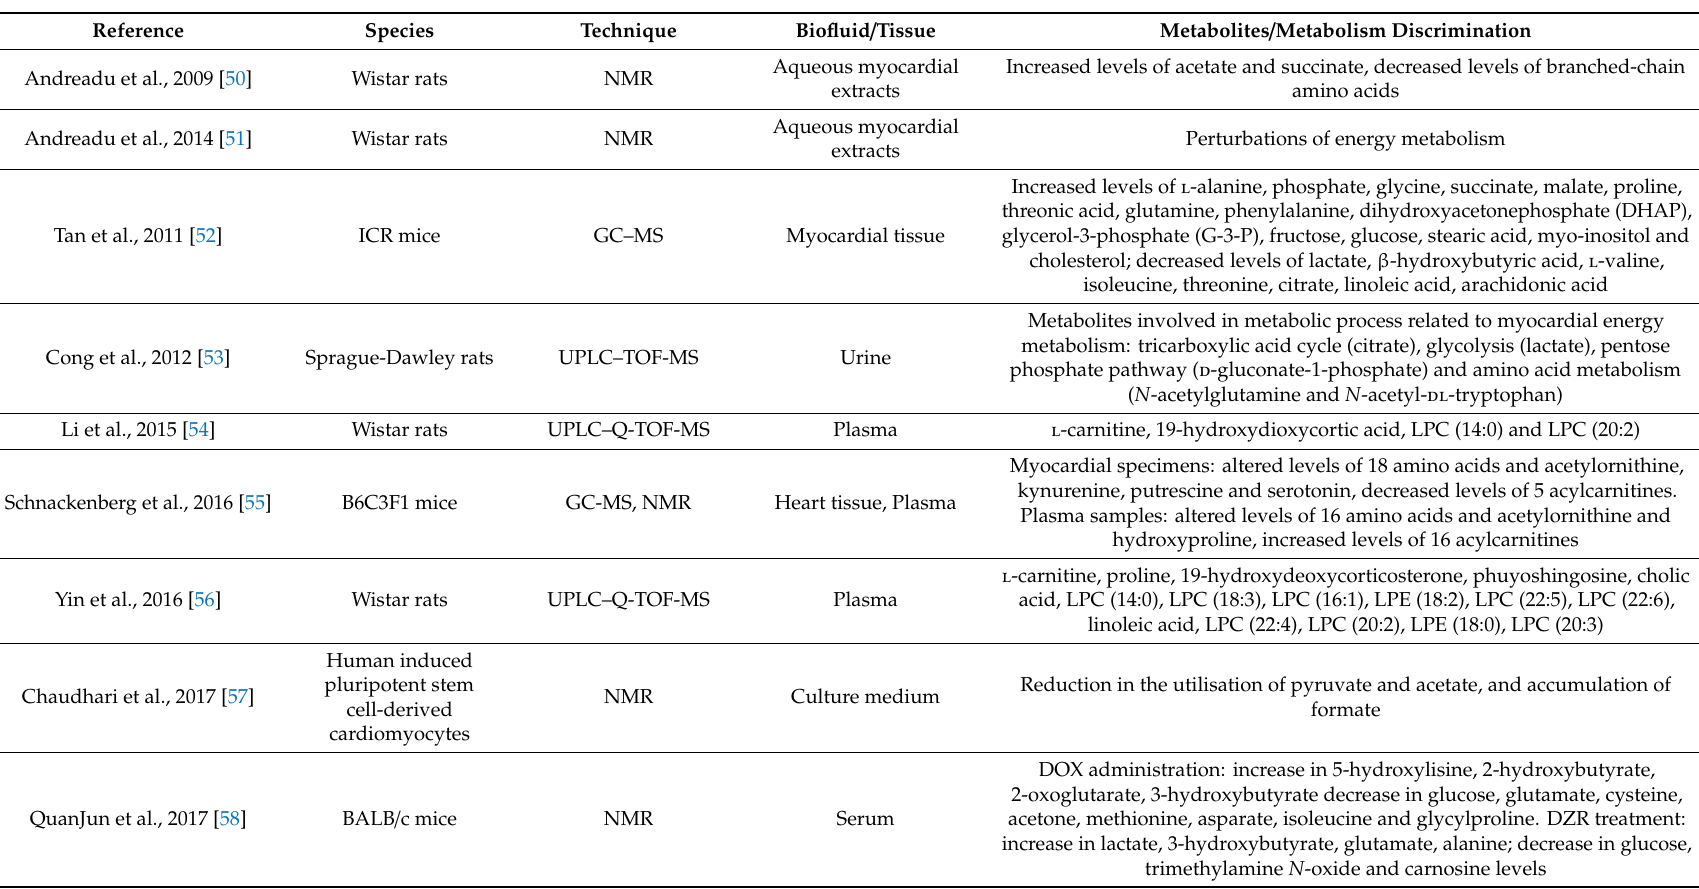
Table 2. Summary of techniques and results of the discussed